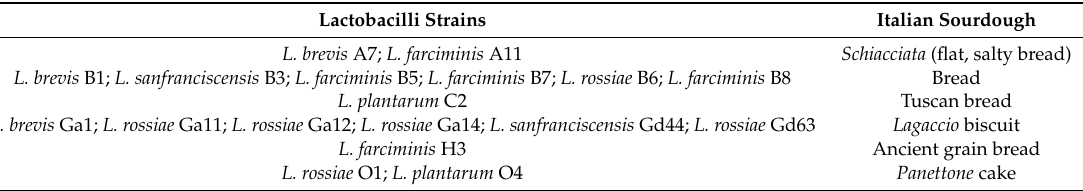
Table 1. Lactobacilli strains and the isolation